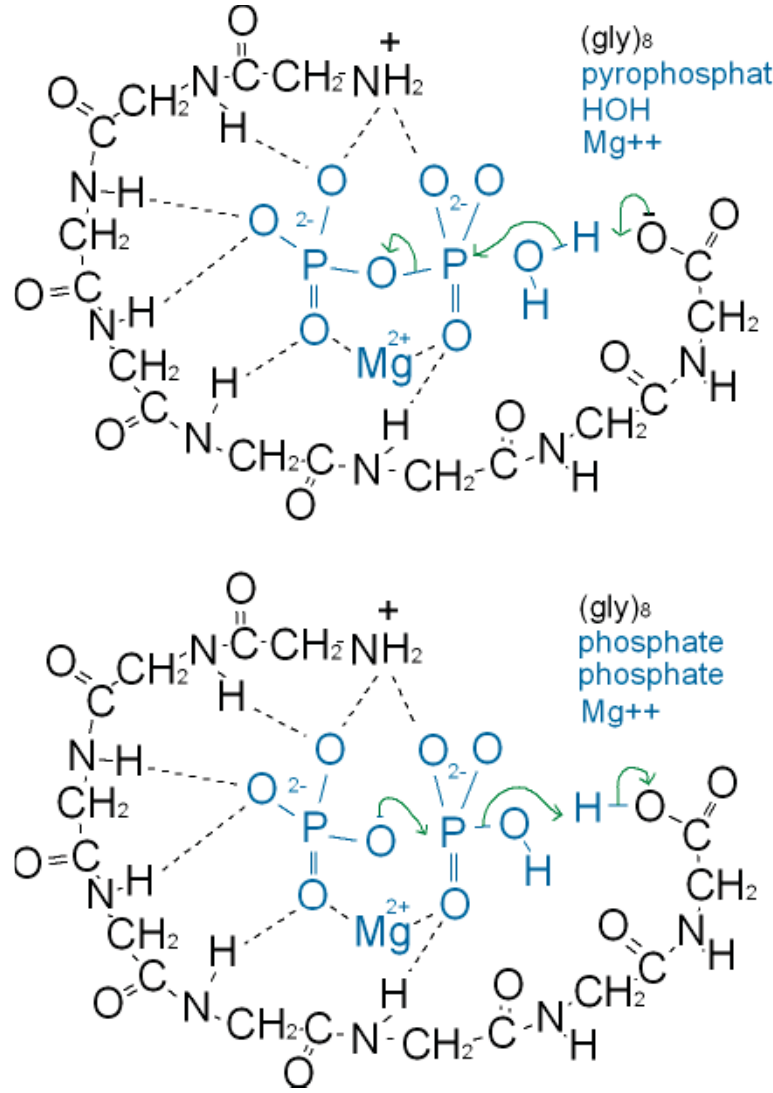
Figure 3. The envisaged pyrophosphate mechanism showing how the main chain atoms of short peptides may catalyze ( a ) the pyrophosphate reaction PPi (cid:2) Pi + Pi and ( b ) the reverse reaction, pyrophosphatase synthase. The protonation states of the phosphates in ( b ) are uncertain. We have assumed that the proximity of the magnesium ion and the nest causes the reacting phosphate at the left to be PO 43 − while the reacting phosphate at the right is HPO 42 − or CH COPO 42 − 3